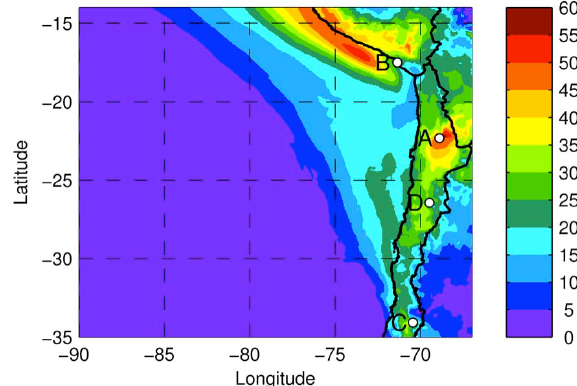
Fig. 6. % change in particle number concentration predicted by WRF-Chem with and without smelter emissions included. Particle size range was matched to the PCASP probe, 0.12 to 3.0µm in di- ameter. Major smelters are shown as circles with (A) Chuquicamata, (B) Ilo, (C) Caletones and (D)